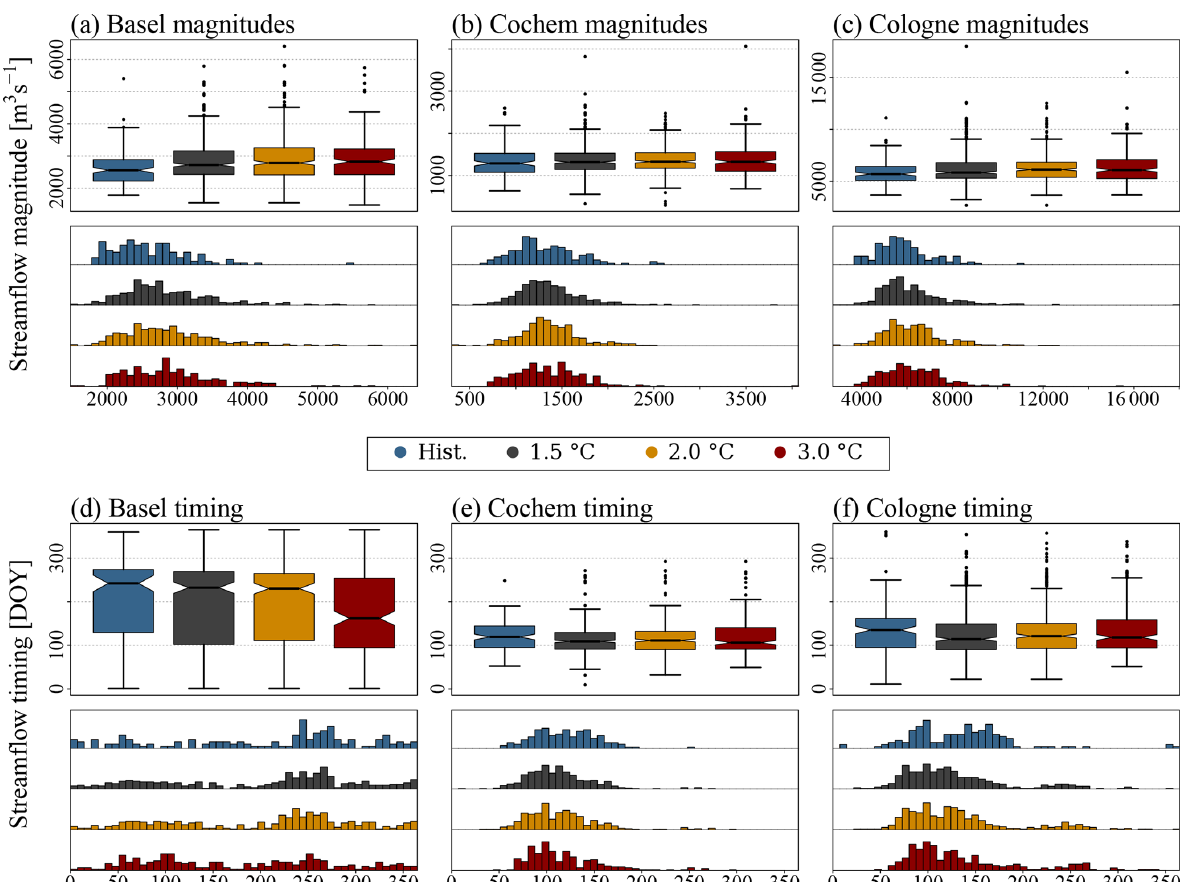
Figure 5. Magnitudes and timing (hydrological year starting on 1 October) of annual streamflow maxima simulated for the gauges at Basel, Cochem and Cologne under selected warming levels (14 GCM–RCP realisations reach 1.5 ◦ C, 13 reach 2 ◦ C and 8 reach 3 ◦ C warming) and displayed as box plots and histograms. Histograms depict probability density and have a total area of